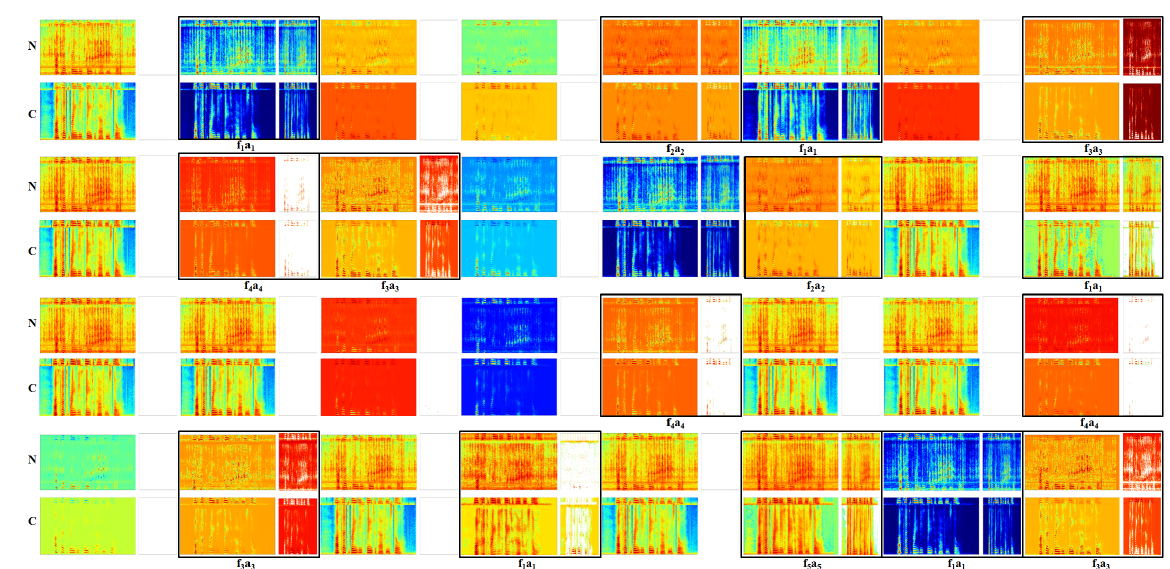
Figure 10. The spectrograms of 32 randomly selected convolution filters (wider spectrogram) and ReLU activation outputs from the first hidden layer of the CNN architecture b , for a processed noisy speech (N) and its clean version (C), f represents convolution filters, a represents activations.